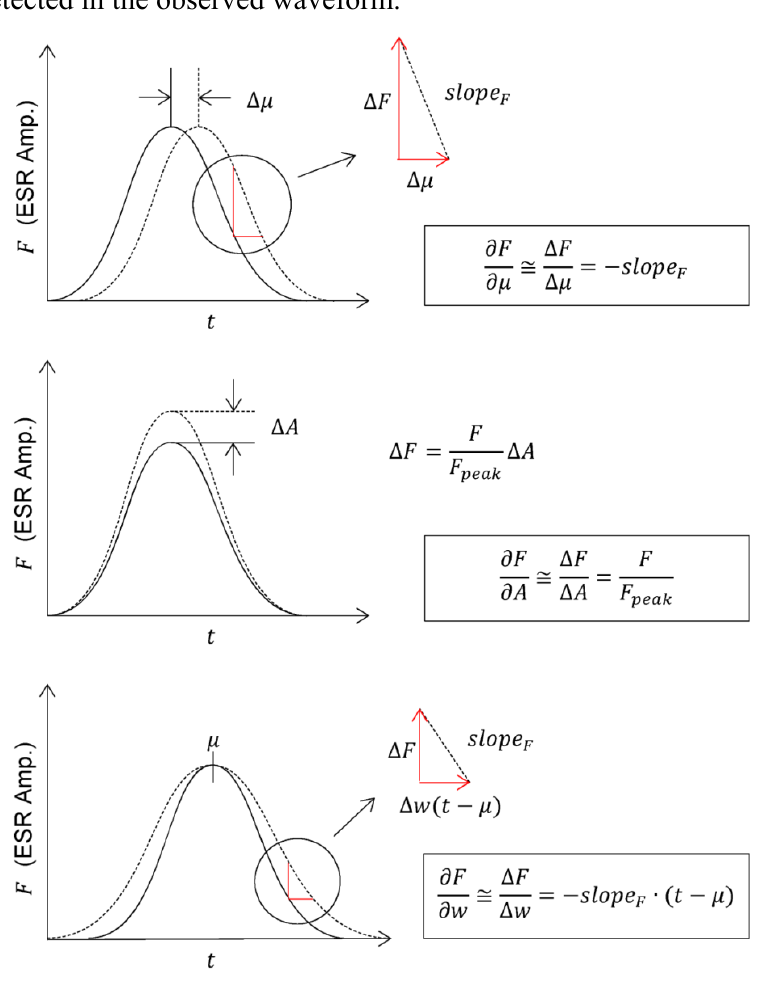
Figure 3. Graphical representation of numeric partial derivatives necessary for the empirical system response least squares waveform decomposition